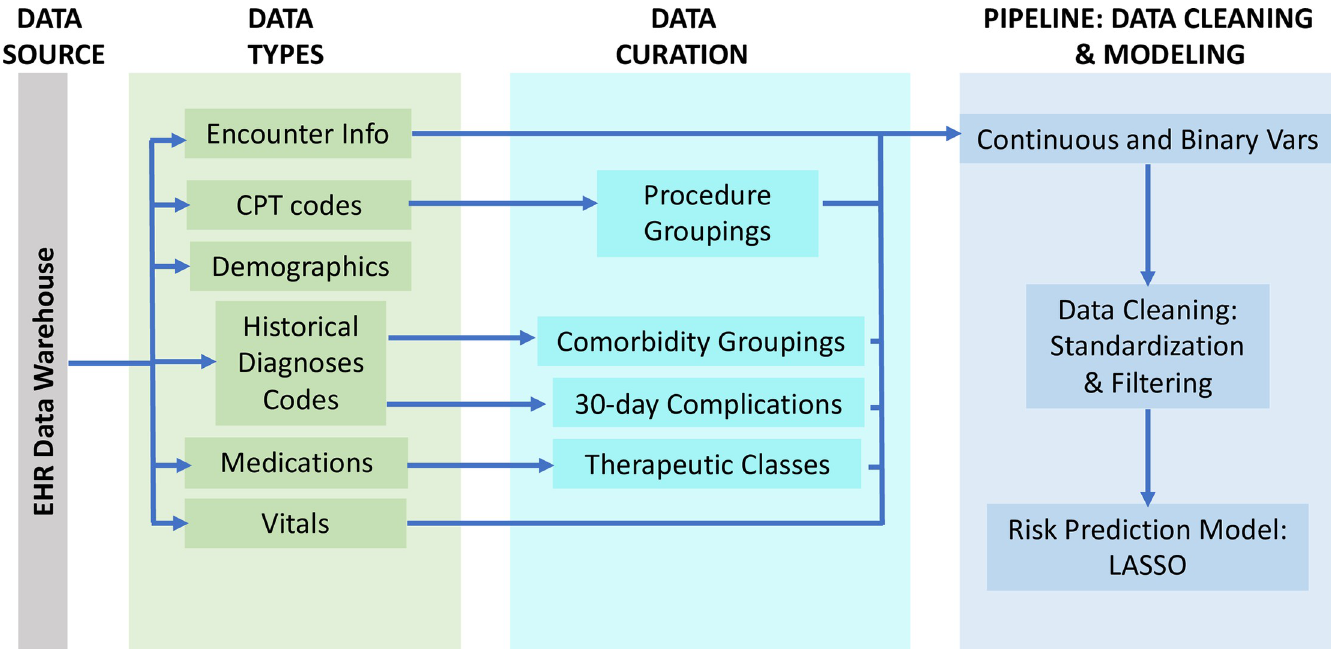
Fig 1. SQL and R code were written to extract, clean, and curate patient data from the electronic health record (EHR) data warehouse. Extracted raw data elements included inpatient and outpatient encounter information, Current Procedural Terminology (CPT) codes, patient demographics, International Classification of Diseases (ICD) codes, medications, and vitals. These elements were curated into clinical features to feed into a cleaning data pipeline to populate Pythia’s data repository. Vars, variables.